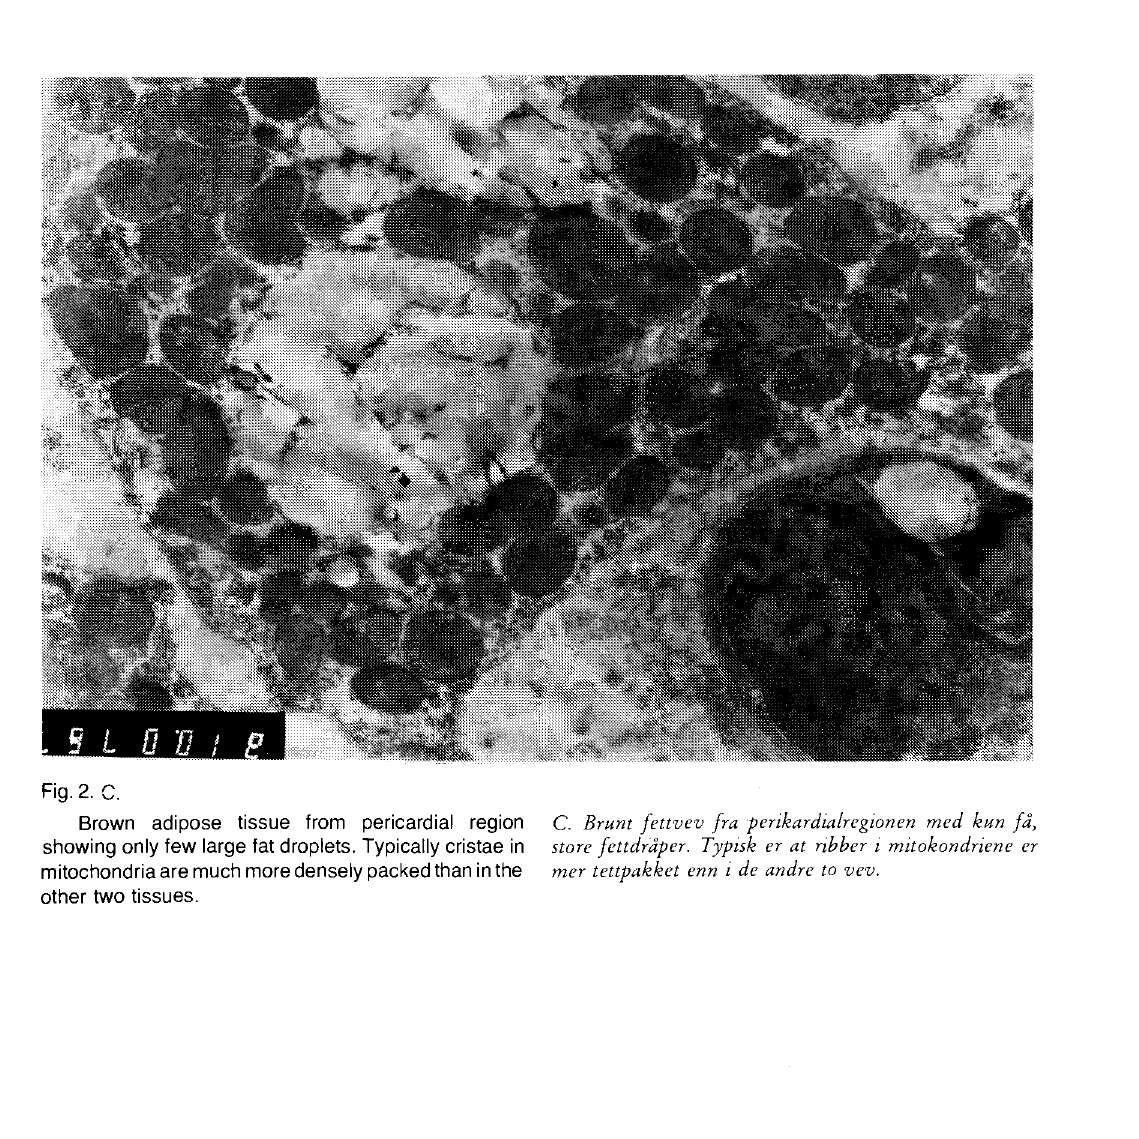
Fig. 2. c. Brown adipose tissue from pericardial